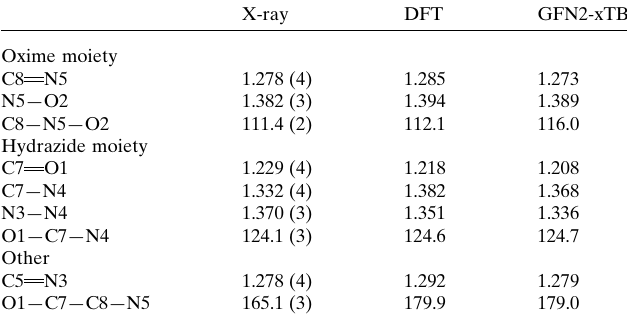
Table 2 Comparison of selected geometric data (A, (cid:3) ) from calculated and X-ray data.